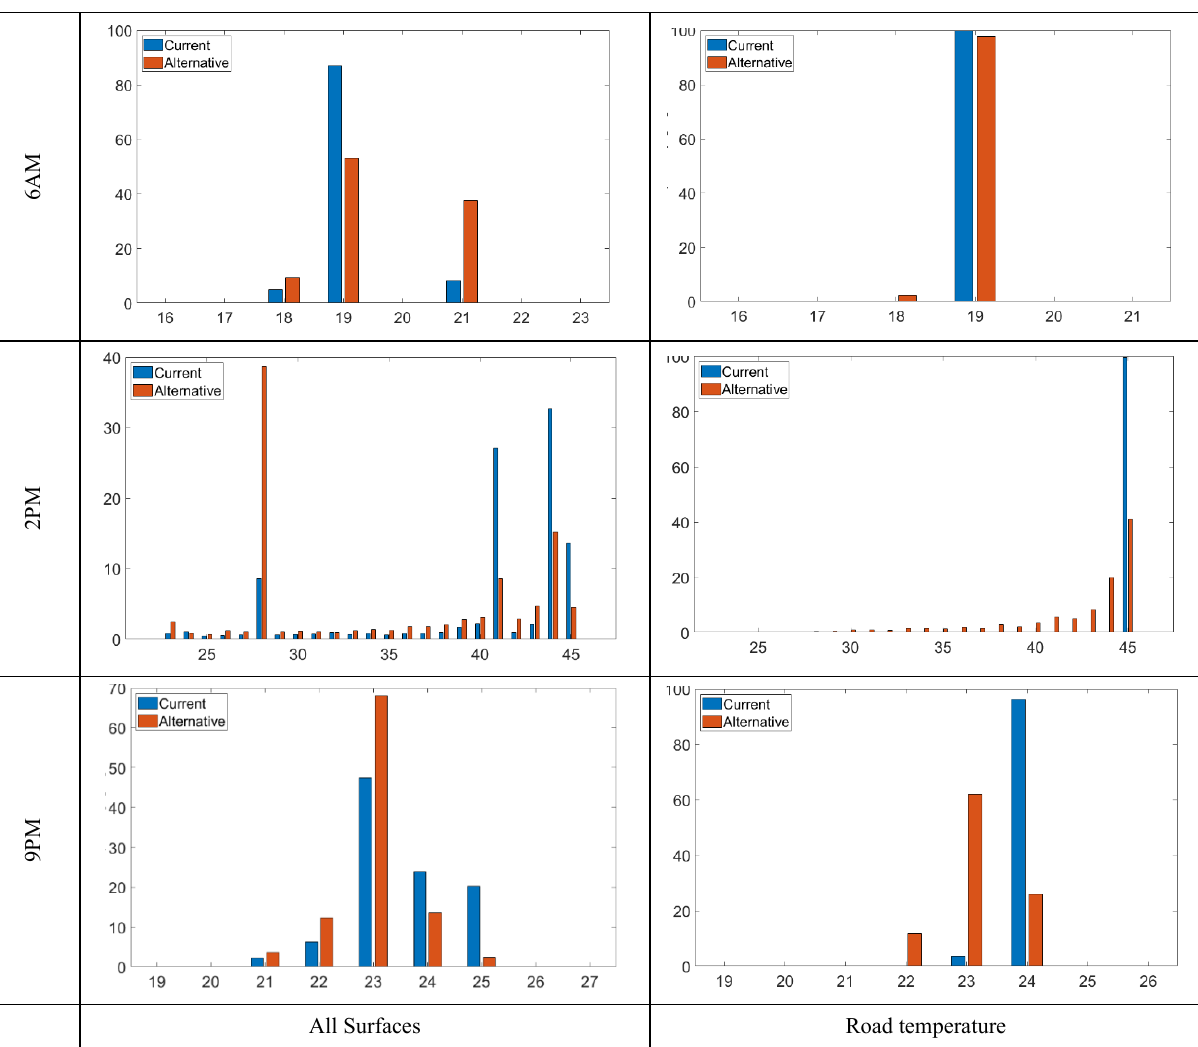
Figure 7: Temperature frequency in percent of all surfaces (left) and of road surface (right) at different